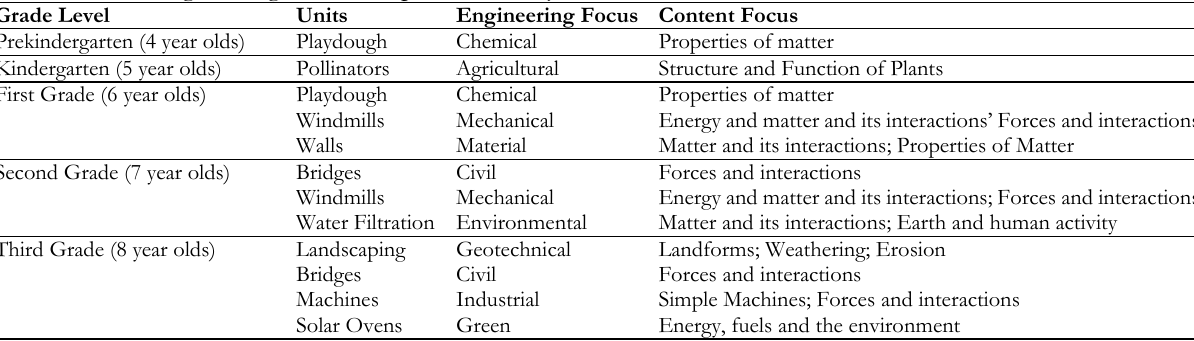
Table 3. Unit Engineering and Conceptual Focus by Grade Level Grade